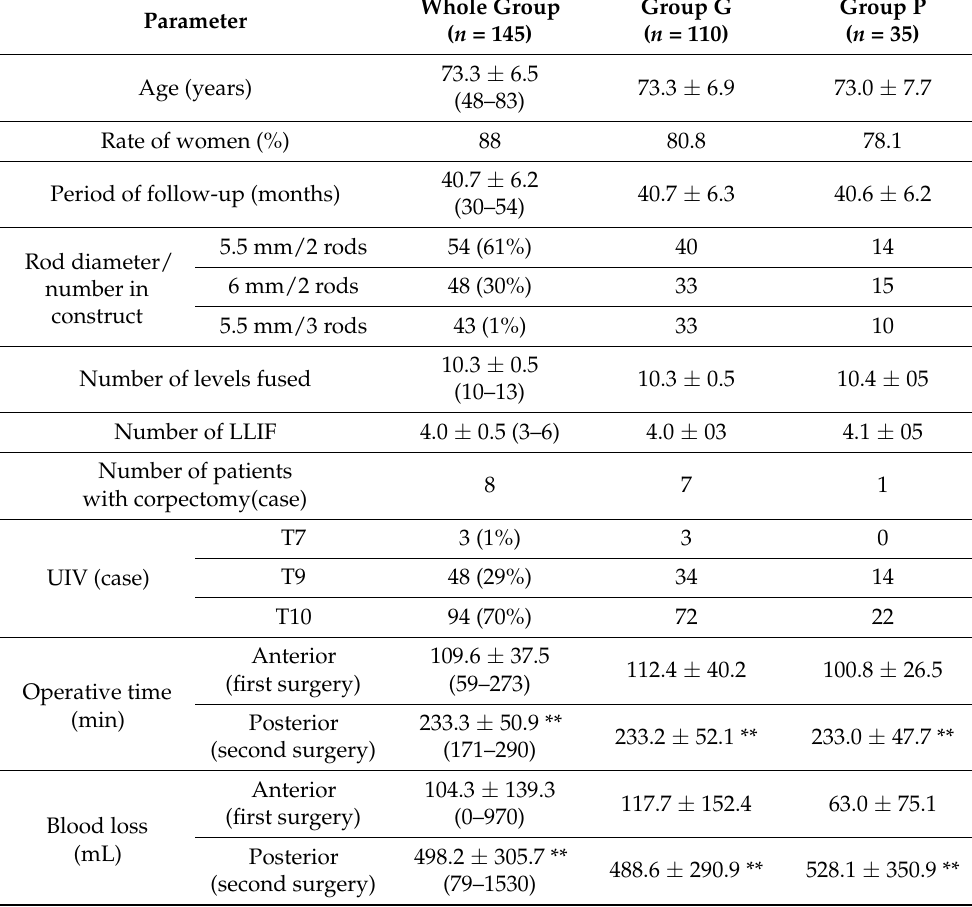
Table 2. Demographic